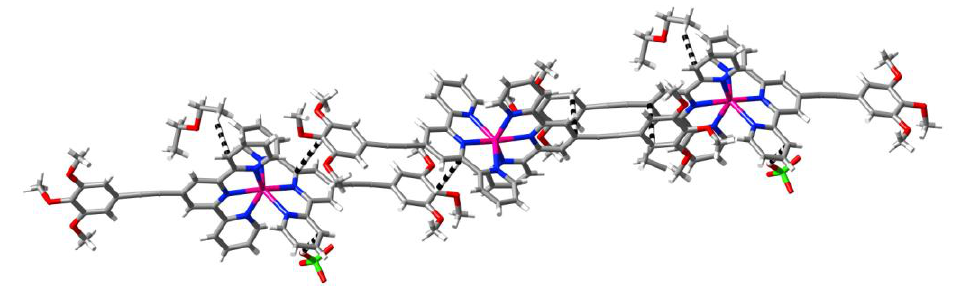
Figure 6. Partial view of a chain of cations within the lattice of [Cd( L2 ) ](ClO ) ∙CH CN∙Et O showing, as black and white dashed lines, π interactions 2 4 2 3 2 which involve the lattice solvent and anions as well as aromatic rings. All C…C contacts (3.31(7) Å) are the same within experimental error, while H and O ClO…C-aromatic is 3.08(6) 3